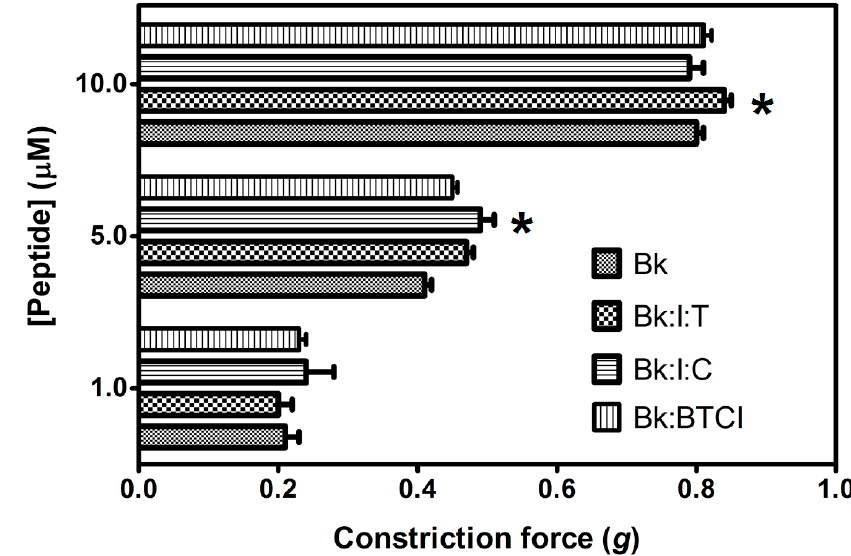
Figure 8. Smooth-muscle constriction assay of Bk in free state (Bk), complexed with BTCI (Bk:I), and complexed with trypsin (Bk:I:T) and chymotrypsin (Bk:I:C). Bk in different concentrations (1.0, 5.0 and 10.0 μ M) was used to evaluate the induced contraction force in guinea pig ileum smooth-muscle * p < 0.05 is compared with all other peptides at the same